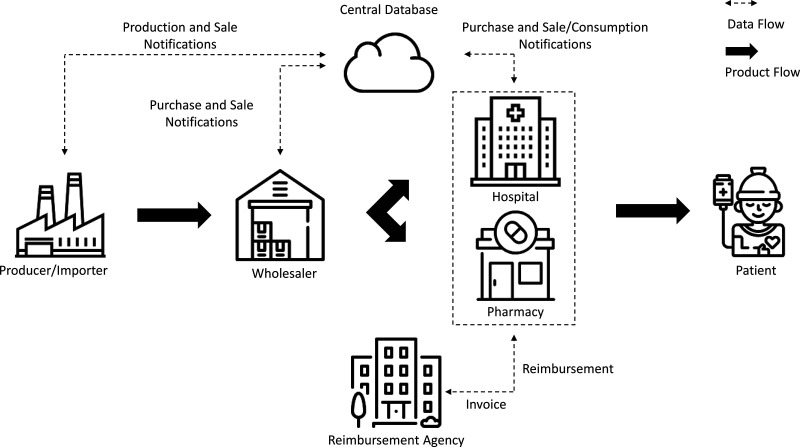
Simplified Schematic Representation of the Workflow of the Full Pharmaceutical Track and Trace System Used in Turkey